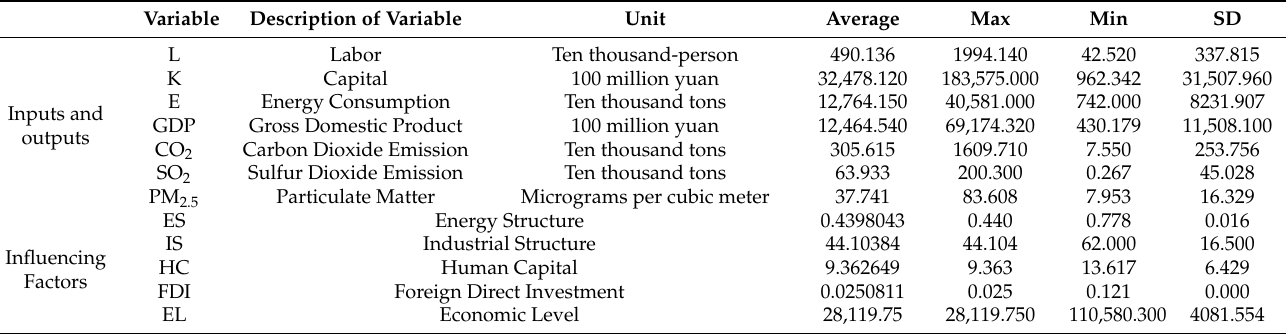
Table 2. Descriptive statistical analysis of variables.